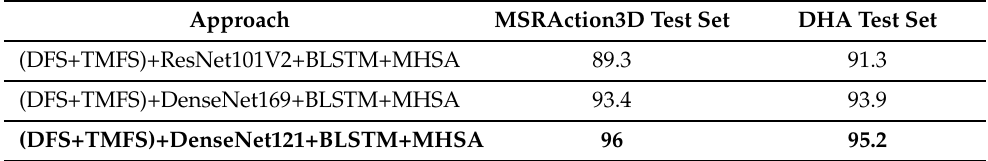
Table 6. Performance of different architectures using four data